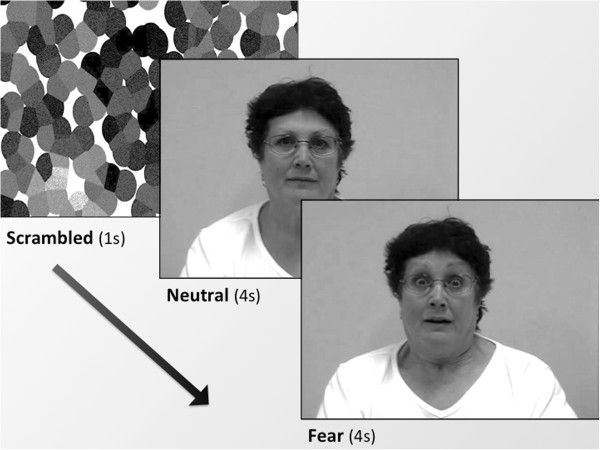
Still frames taken from video stimuli. The time between the Neutral and Fear frames varied slightly between ‘actor’ to 'actor' (M = 2.167 s, SD = 0.600 s).e